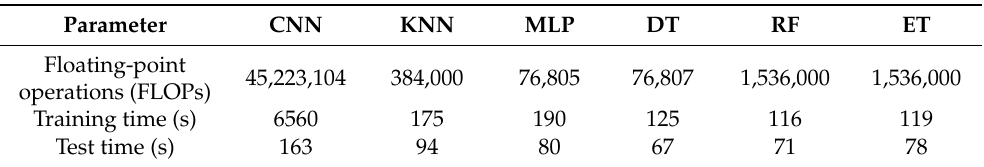
Table 3. Computational costs and complexities for the CNN, KNN, MLP, DT, RF, and ET classifiers on the hologram